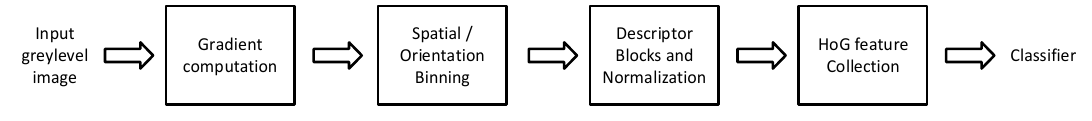
Figure 7. An overview of the feature extraction and object detection chain.